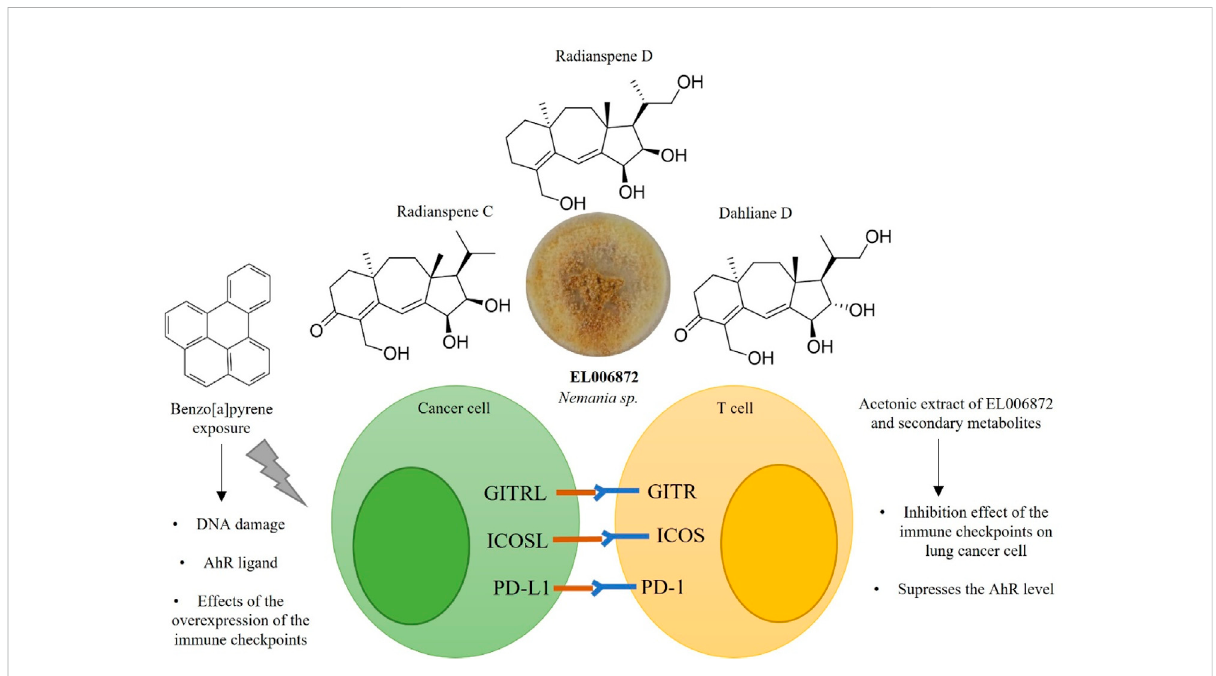
FIGURE 7 Schematic overview of the immune checkpoint inhibitory activity of diterpenoid compounds isolated from Nemania sp.